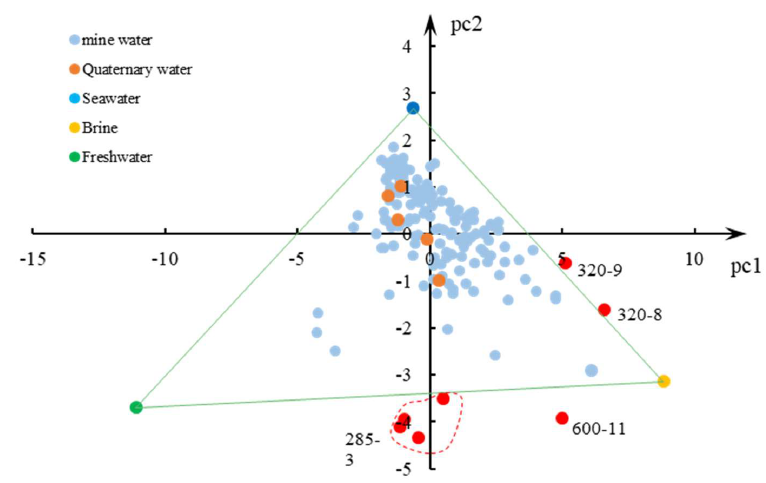
Figure 5. Relationship between pc1 (principal component 1) and pc2 of all water samples.